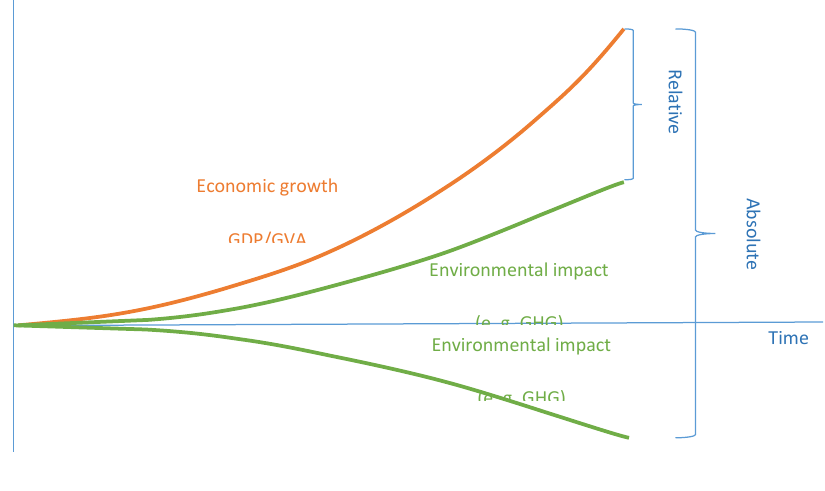
Figure 2. Decoupling between GHG emissions and GVA (modified from Finel and Tapio,